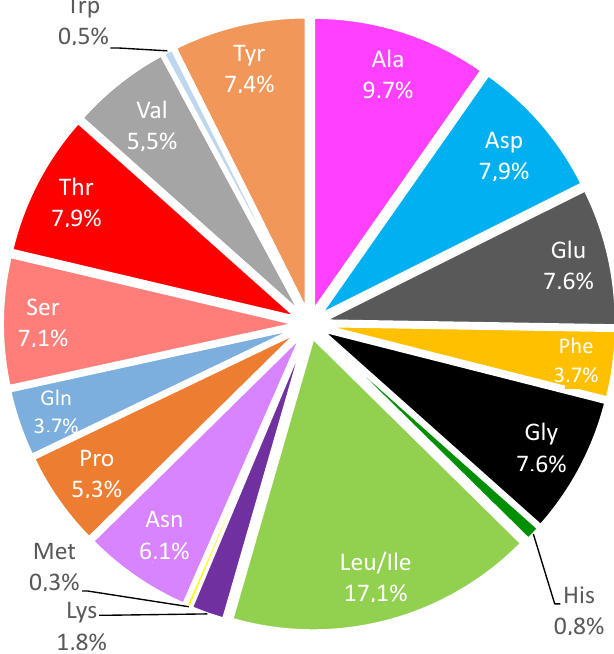
Figure 4. Amino acid composition of the 88 peptides identified in the H-PROT-1 (t1h) fraction by UHPLC-HRMS. Table 2. Peptide sequences identified by UHPLC-HRMS in the H-PROT-1 (t1h) fraction.